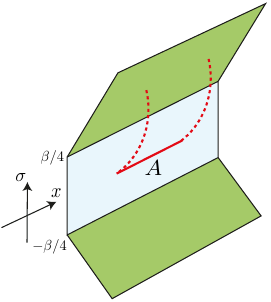
Figure 11 . Ryu-Takayanagi surfaces (dotted red lines) for the subregion A in terms of AdS/BCFT ending at the EOW brane emanated from σ = β/ 4 boundary. This situation corresponds to the case when twist operators for A contract with the boundary at σ = β/ 4 . When the boundary conditions at σ = ± β/ 4 are identical and the total system size is sufficiently large, the two EOW branes are connected, and the boundary correlation functions behave thermally. When one of two conditions is not satisfied, the EOW branes are disconnected, and RT surface can end on both EOW